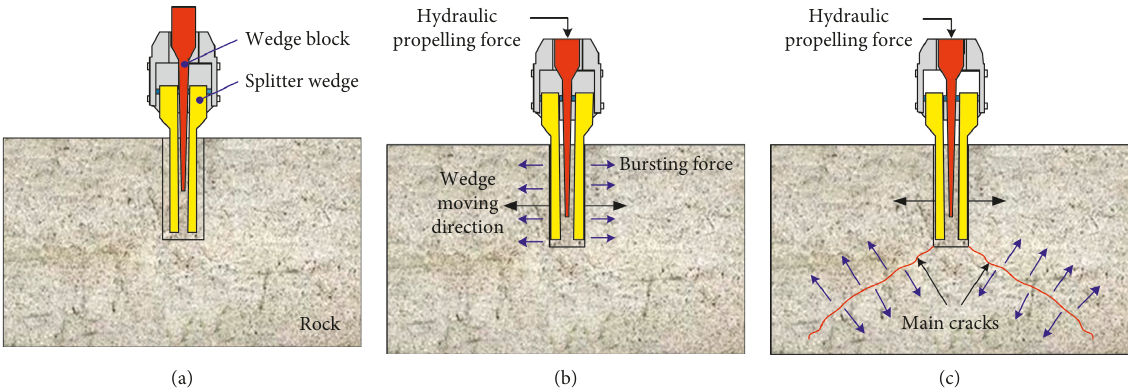
Figure 1: Rock-breaking process using hydraulic splitter: (a) insertion of hydraulic splitter; (b) hydraulic propelling action; (c) rock fracturing.